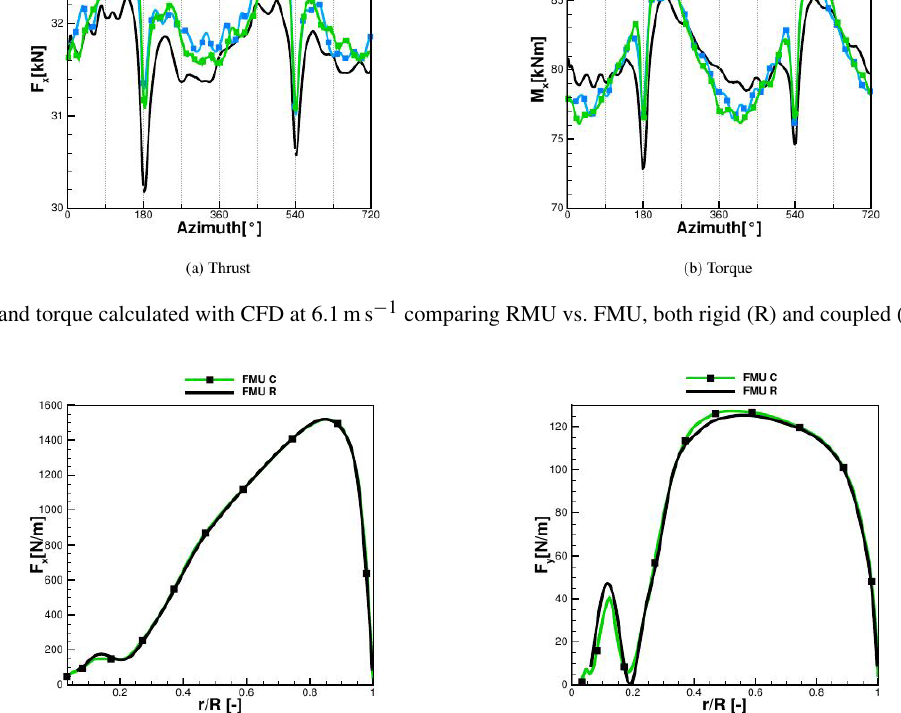
ter two revolutions, oscillating flapwise with an average of 2.45 % of the blade length. The same convergence trend can be seen for the edgewise deformation and for the torsion, both of them almost negligible. All three are oscillating ac- cording to the rotational